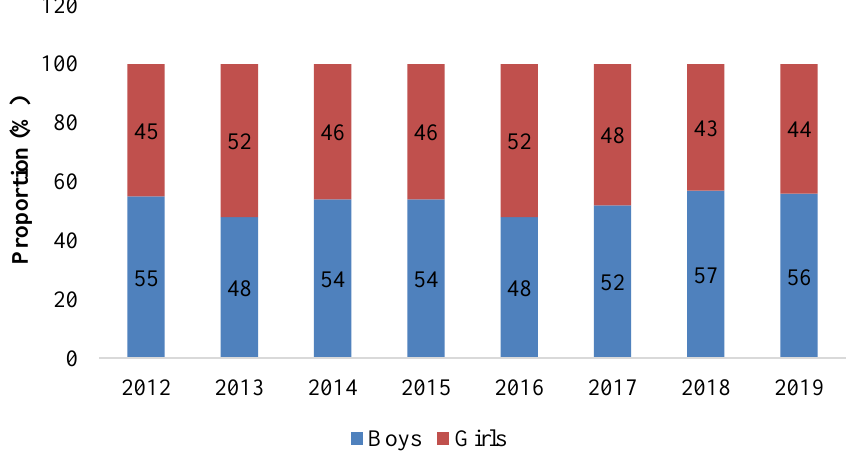
Fig. 6. Structural analysis of LGM sick children in 201–-2018, including 2019 data (morbidity prediction results) by